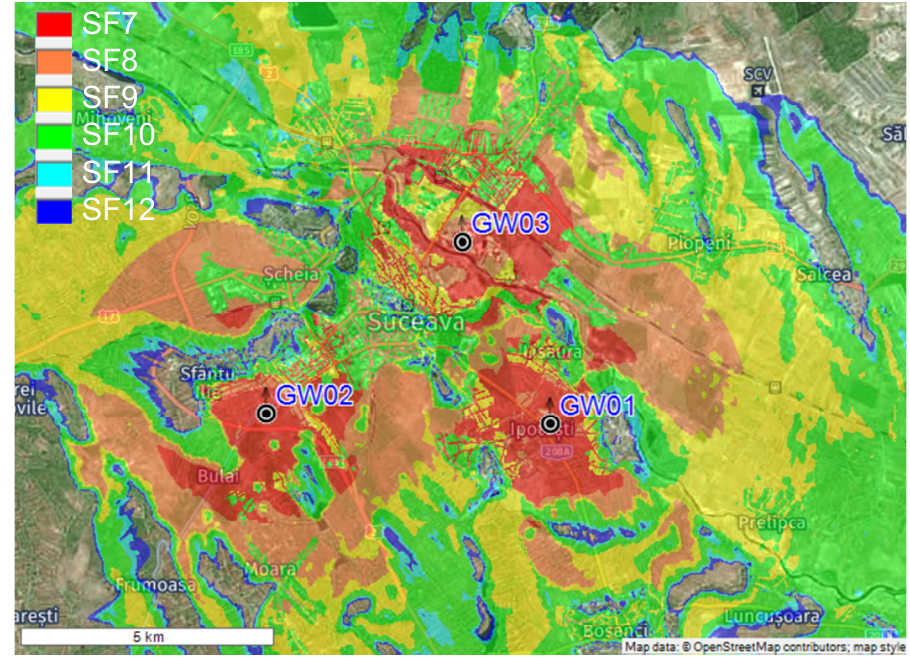
Figure 9. Field coverage measurements—multiple GW configuration. The GW used in the field tests of the system runs ChirpStack Gateway OS [45], which has the capabilities to decode, store and forward the LoRaWAN packets to external applications under JSON application format. Figure 10 presents the monitoring and control application user interface of the application dashboard. The application is developed as an interactive map that can be easily displayed to the medical staff. The information shown includes the GPS location of each individual patient, his/her vital signals in a build-in graph window, the battery level of the device, the isolation period for each patient and specific alarms based on the threshold setup by the medical staff in the configuration settings of the integrated system.